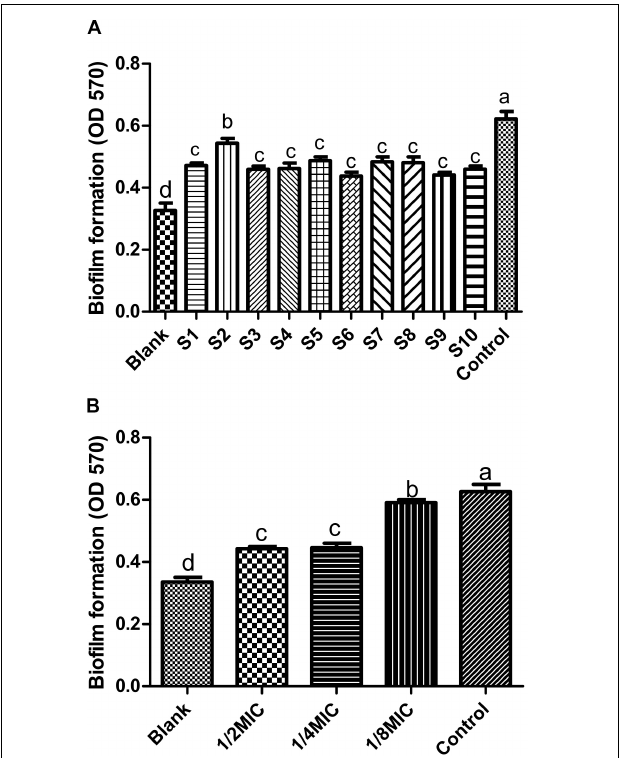
FIGURE 6 | Modeled structure of CAT protein from Streptococcus suis.